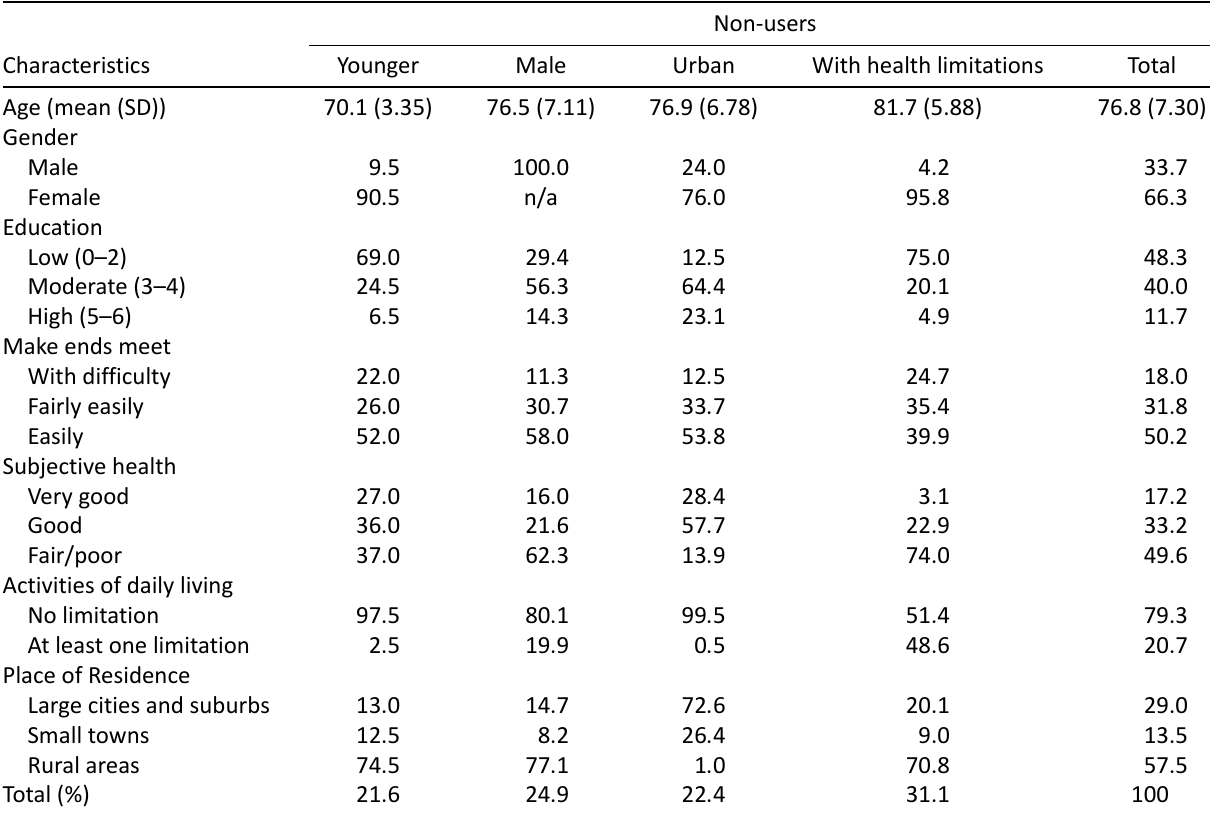
Table 3. Characteristics of the cluster groups (%).